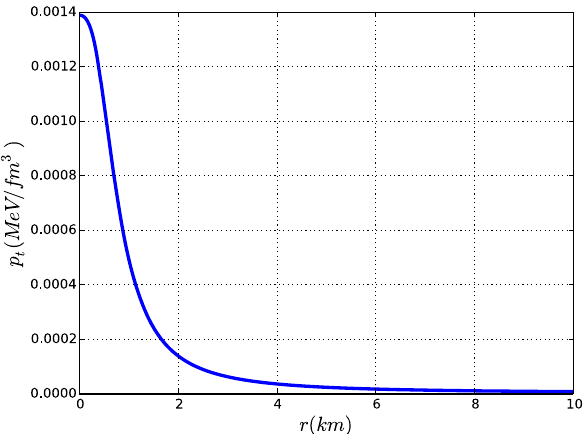
Fig. 11 Strong energy condition against radial distance